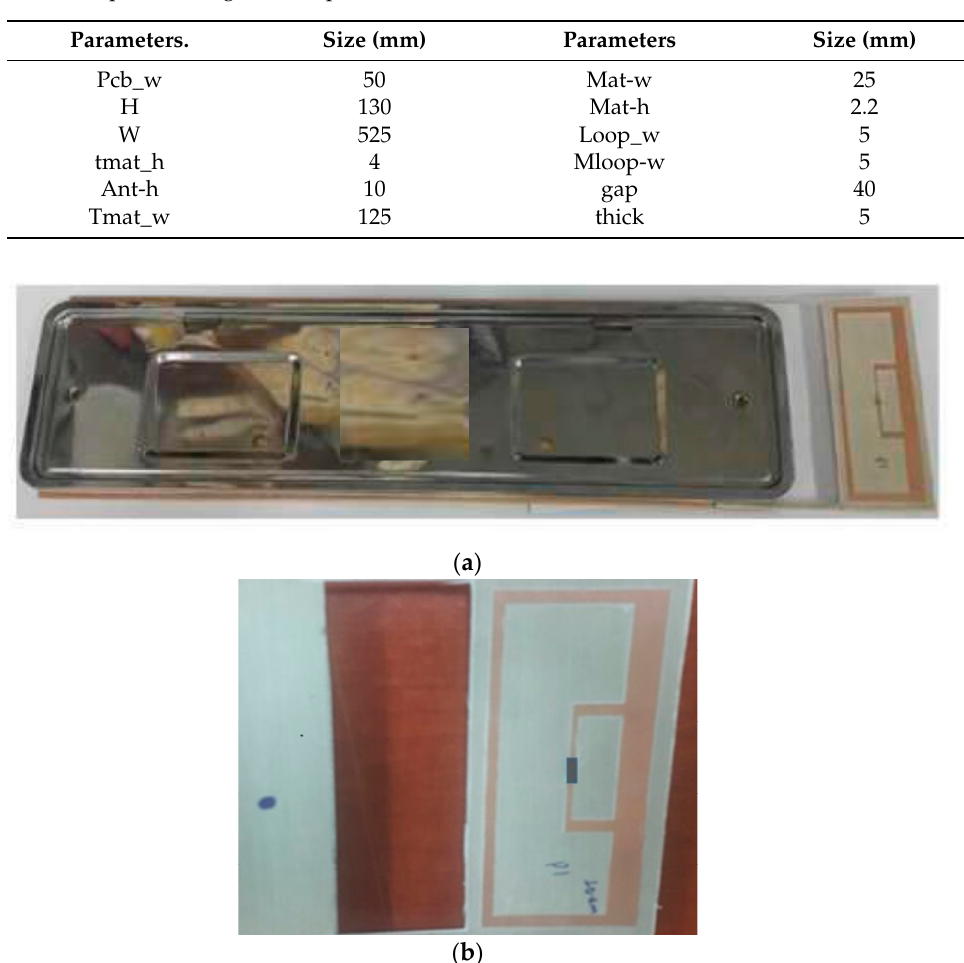
Figure 6. ( a ) Fabricated tag antenna with the plate holder (bumper side). ( b ) Fabricated prototype tag antenna.